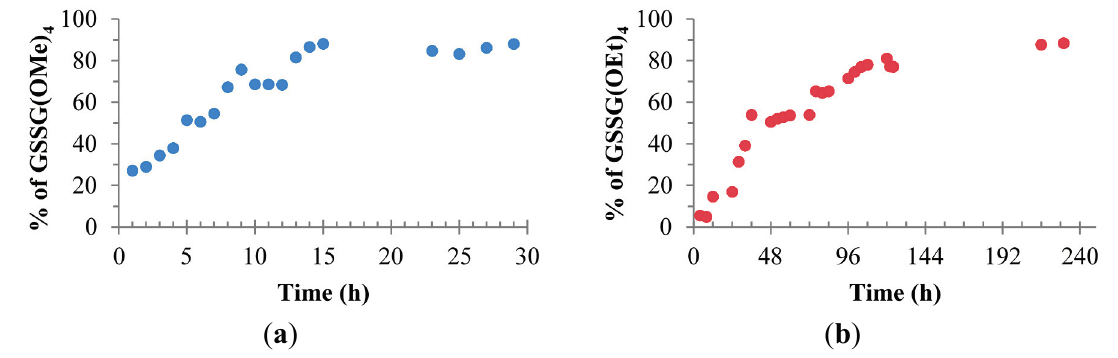
Figure 1. ( a ) Plot of the percent conversion to the GSSG tetra esters vs. time in methanol as determined by ESI-MS ( b ) Plot of the percent conversion to the GSSG tetra esters vs. time in ethanol as determined by ESI-MS.